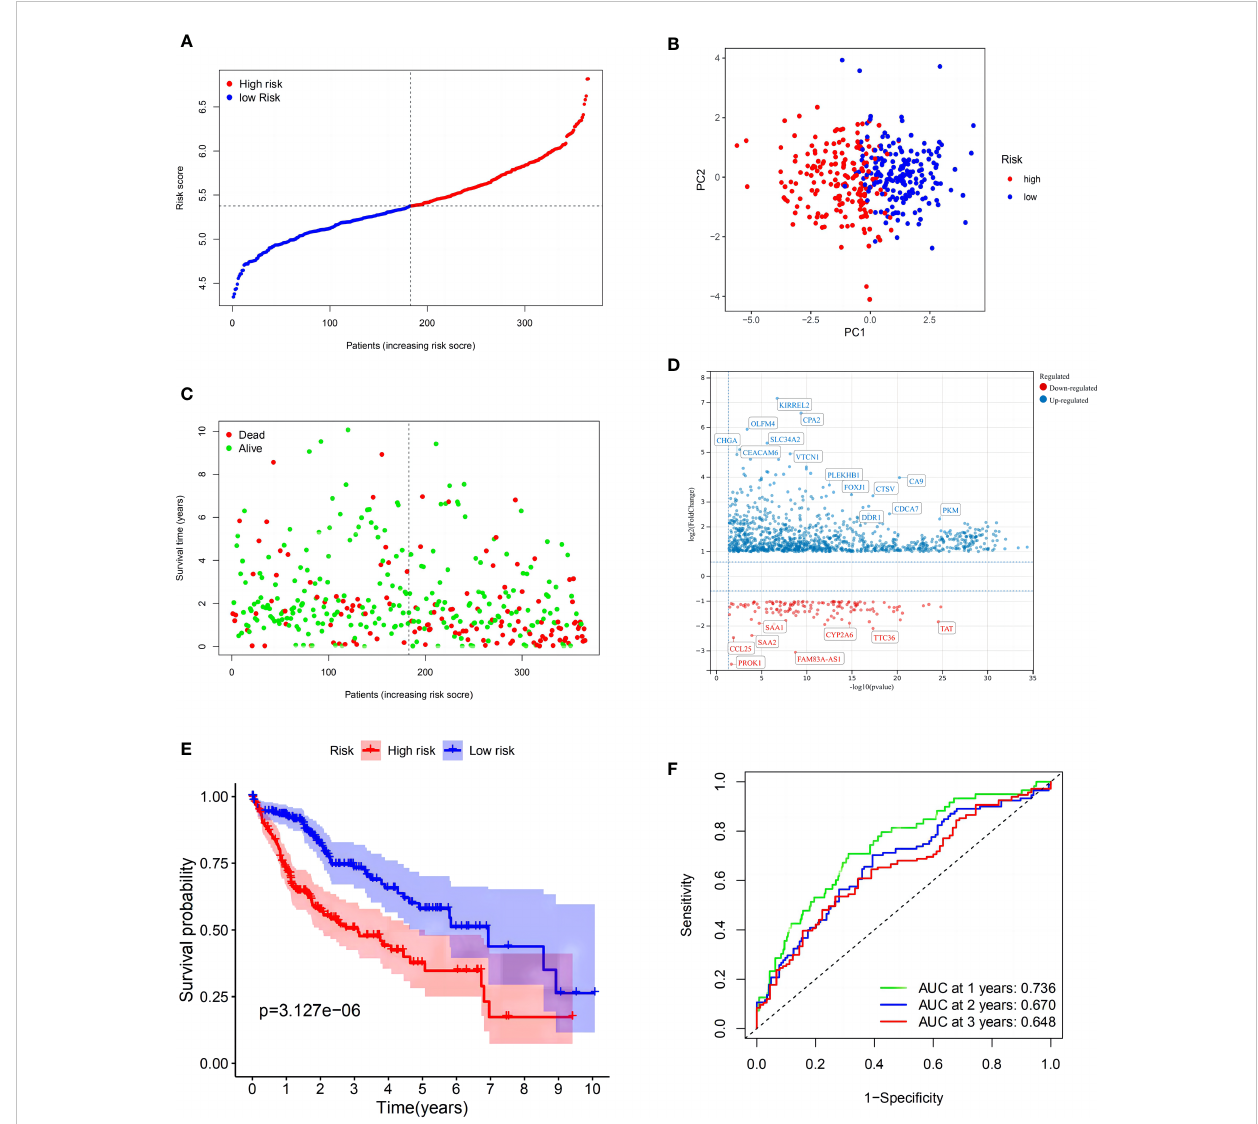
FIGURE 2 Construction of the risk signature in The Cancer Genome Atlas (TCGA) cohort. (A) Distribution of patients based on the risk score. (B) PCA plot for hepatocellular carcinomas (HCCs) based on the risk score. (C) The survival status for each patient (low-risk population: on the left side of the dotted line; high-risk population: on the right side of the dotted line). (D) Volcano plot showing the signi fi cant DEGs with FDR <0.05 and |log2FC| >1 between two macropinocytosis score groups. (E) Kaplan – Meier curves for OS of patients in the high- and low-risk groups (blue: low-risk group; red: high-risk group). (F) ROC curves showing the predictive ef fi ciency of the risk